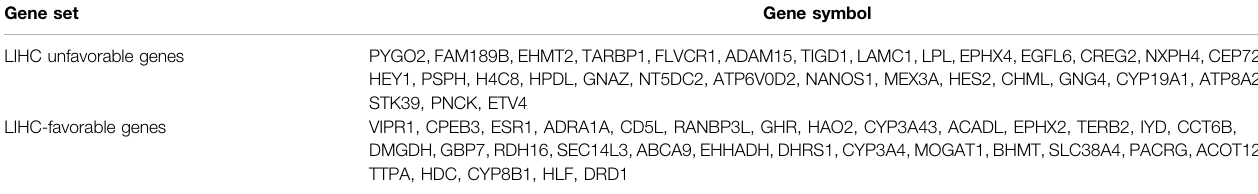
TABLE 1 | LIHC-unfavorable gene set and LIHC-favorable gene set. Gene set